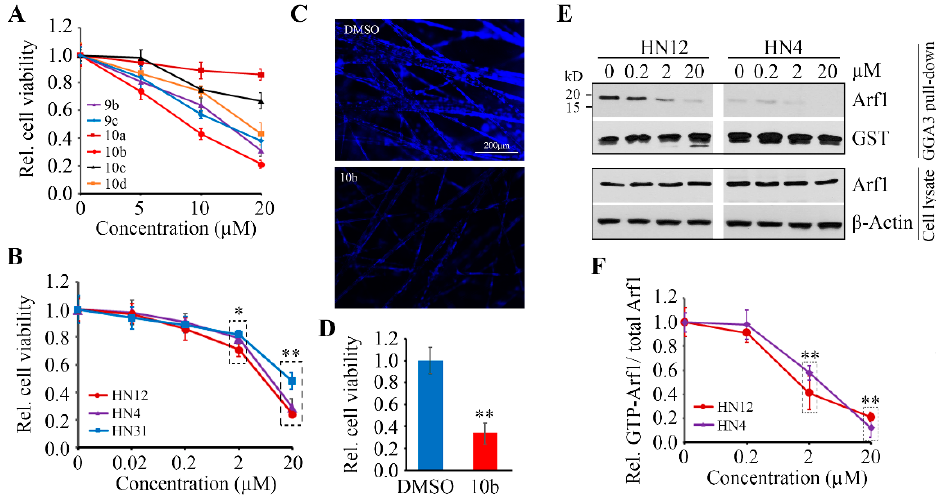
Figure 5. The anticancer effects of Arf1-targeting compounds. ( A ) The effects of Arf1-targeting compounds ( 9b , 9c , 10a , 10b , 10c , and 10d in a range dose from 0 to 20 µ M) on HN12 cell viability were determined by CellTiter-Glo ® Luminescent cell viability assay after 72 h treatment. ( B ) The dose-dependent cytotoxicity of compound 10b in three HNSCC cell lines (HN4, HN12, and HN31) was determined by CellTiter-Glo ® Luminescent cell viability assay after 72 h treatment. ( C,D ) The effects of 20 µ M of compound 10b on HN12 cell viability in SeedEZ was determined after 72 h treatment. Representative images of DAPI staining and quantitative data of cell viability measured by alamarBlue are shown in ( C , D ), respectively. ( E , F ) Arf1 protein levels and its activity in HN12 and HN4 cells treated with or without compound 10b were determined by GGA3 pull-down assay and Western blotting. A representative result and quantitative data from three independent experiments are shown in ( E , F ), respectively. * p < 0.05; ** p < 0.01.